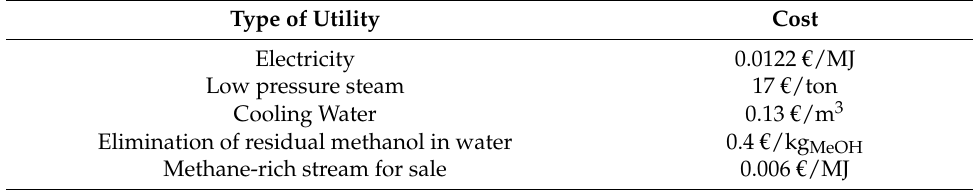
Table A1. Cost of each used utility.